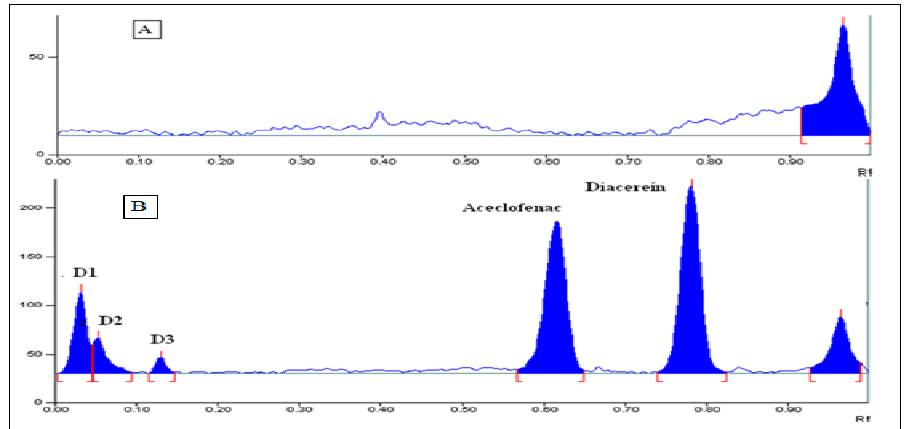
Figure 3. A- Blank HCl, B- Mixture (500 ng/band) treated with